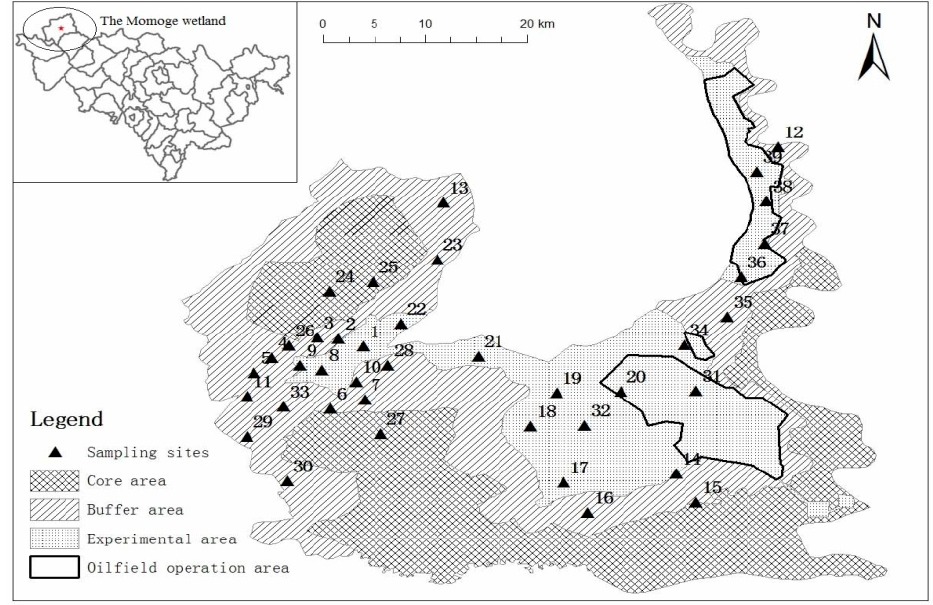
Figure 1. Location of sampling sites in the Momoge Wetland.